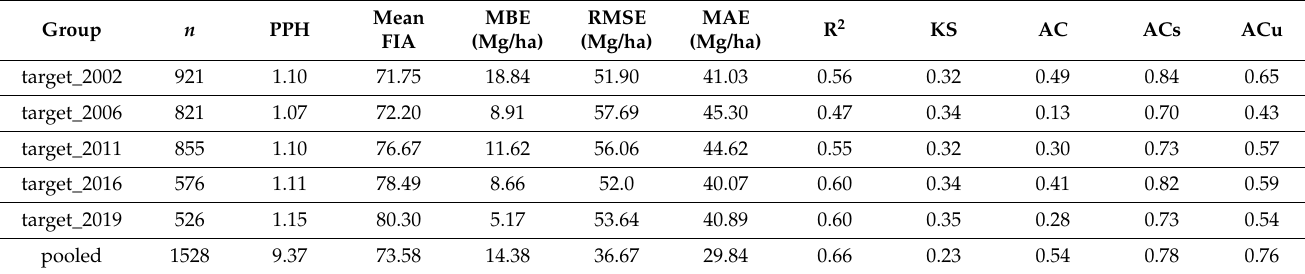
Table 3. Agreement statistics (SI-corrected)—8660 Ha Hex.